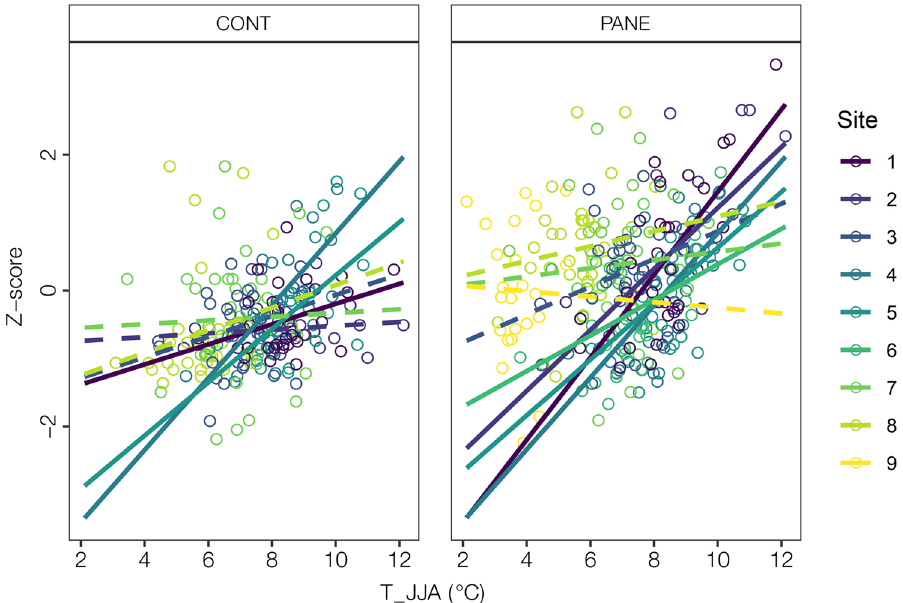
Figure 5. Linear regressions of climate sensitivity of individual growth time series to summer temperatures (T_JJA) for the different sites. Solid and dashed lines indicate significant ( p < 0.05) and not significant ( p > 0.05) relationship, respectively. The colour gradient (from dark to light) identifies the different sites located along the ice-sea